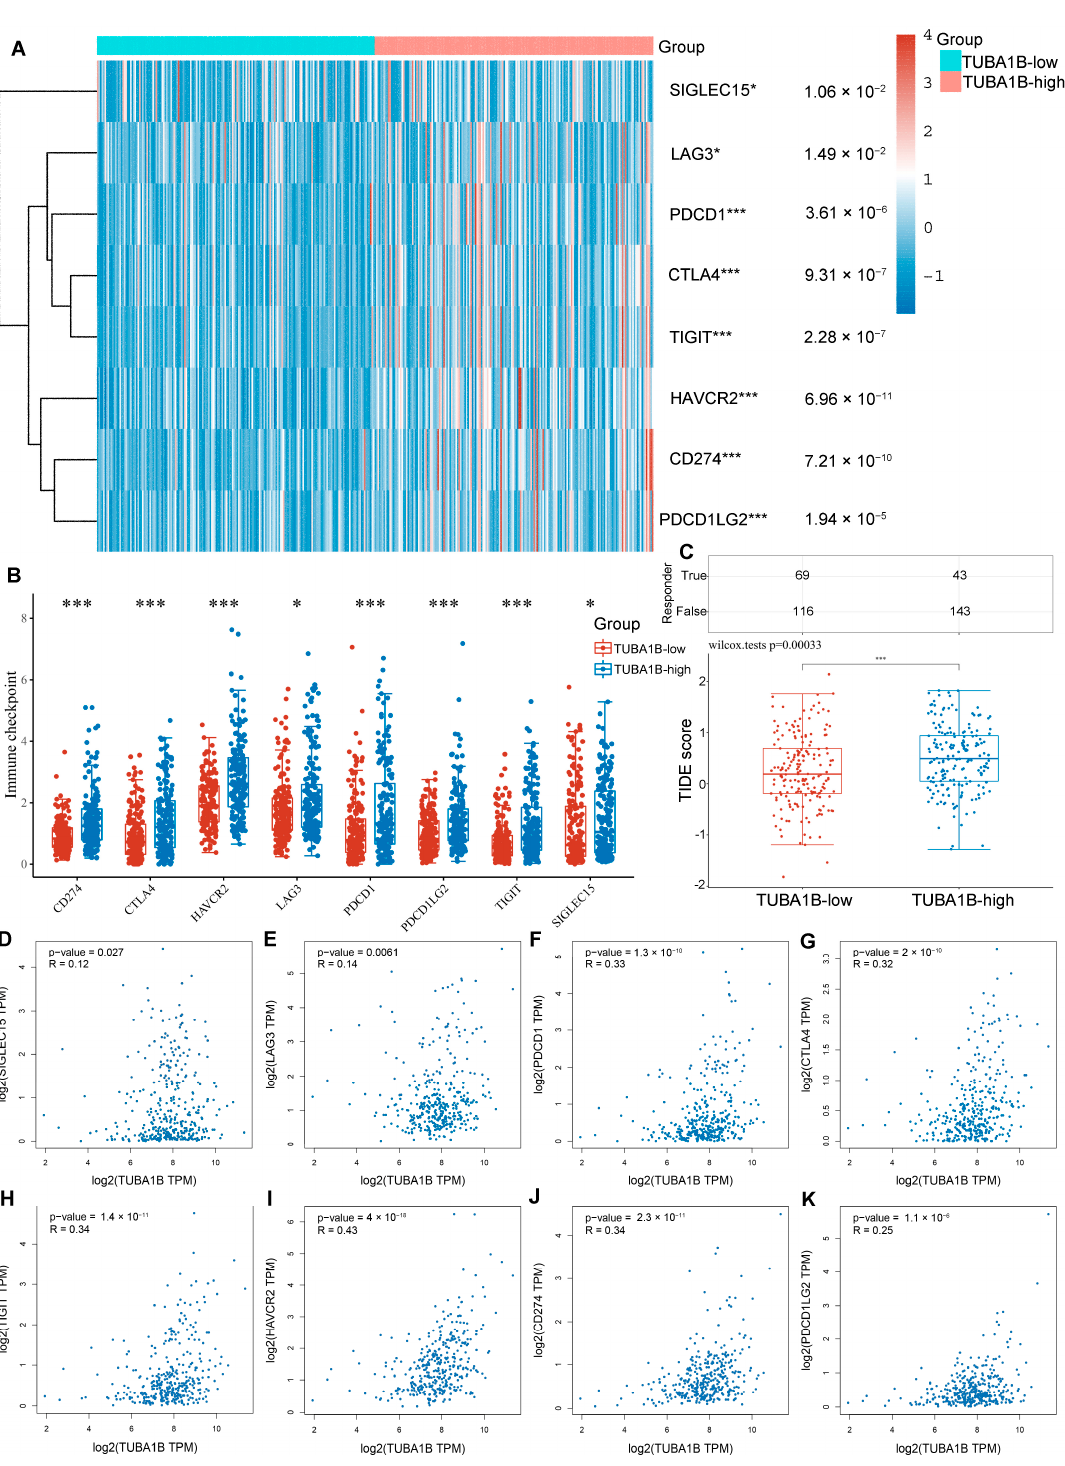
Figure 5. The relationship between TUBA1B expression and immune checkpoints and patients’ response to immunotherapy. ( A ) Heat map of the correlation between immune checkpoint genes expression and TUBA1B expression in HCC. ( B ) Histogram of the association between immune checkpoint genes expression and TUBA1B expression in HCC. ( C ) Relationship between TIDE scores and TUBA1B expression in HCC. The relationship of TUBA1B expression with the expres- sion of SGLEC15 ( D ), LAG3 ( E ), PDCD1 ( F ), CTLA4 ( G ), TIGIT ( H ), HAVCR2 ( I ), CD274 ( J ), and PDCD1LG2 ( K ). * p < 0.01, *** p <